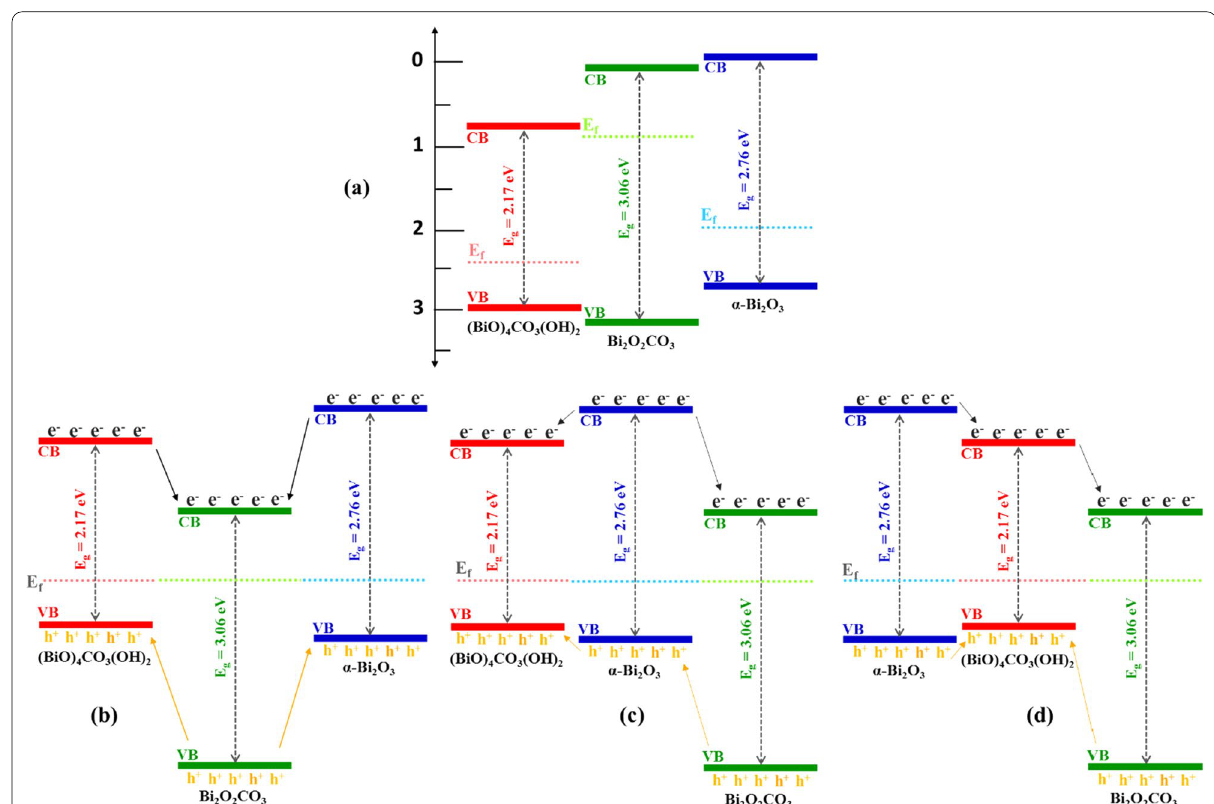
Fig. 10 Schematic diagram of three possible photogenerated charge separation for Bi 2 O 3 /Bi 2 O 2 CO 3 /(BiO) 4 CO 3 (OH) 2 , a before multi-heterojunctions formation, b–d after multi-heterojunctions formation